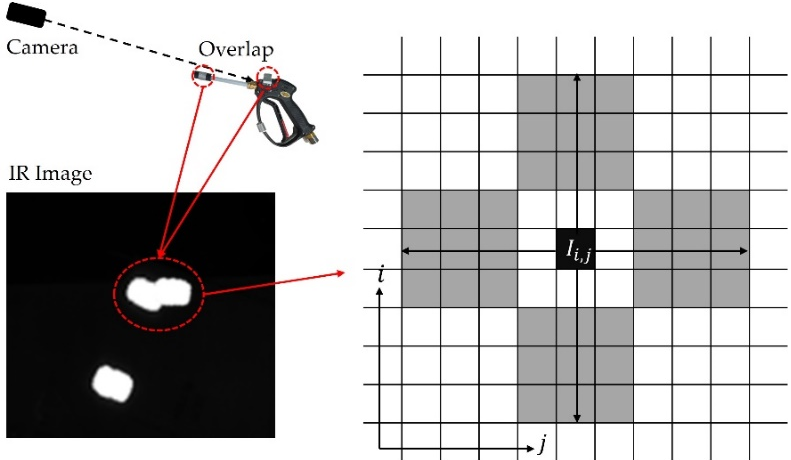
Figure 11. Estimation of the 3D marker position on the tool by searching the neighbor pixels around the center of the marker pixel on an IR image.